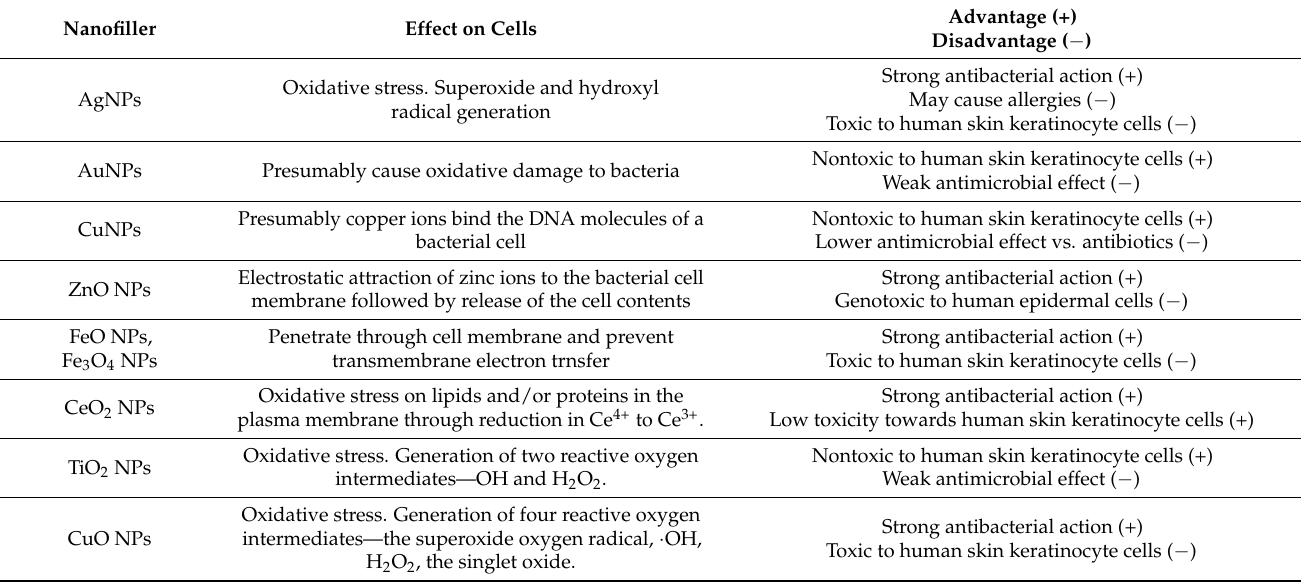
Table 4. The action, the advantages and disadvantages of the nanoparticles used for wound dress- ing